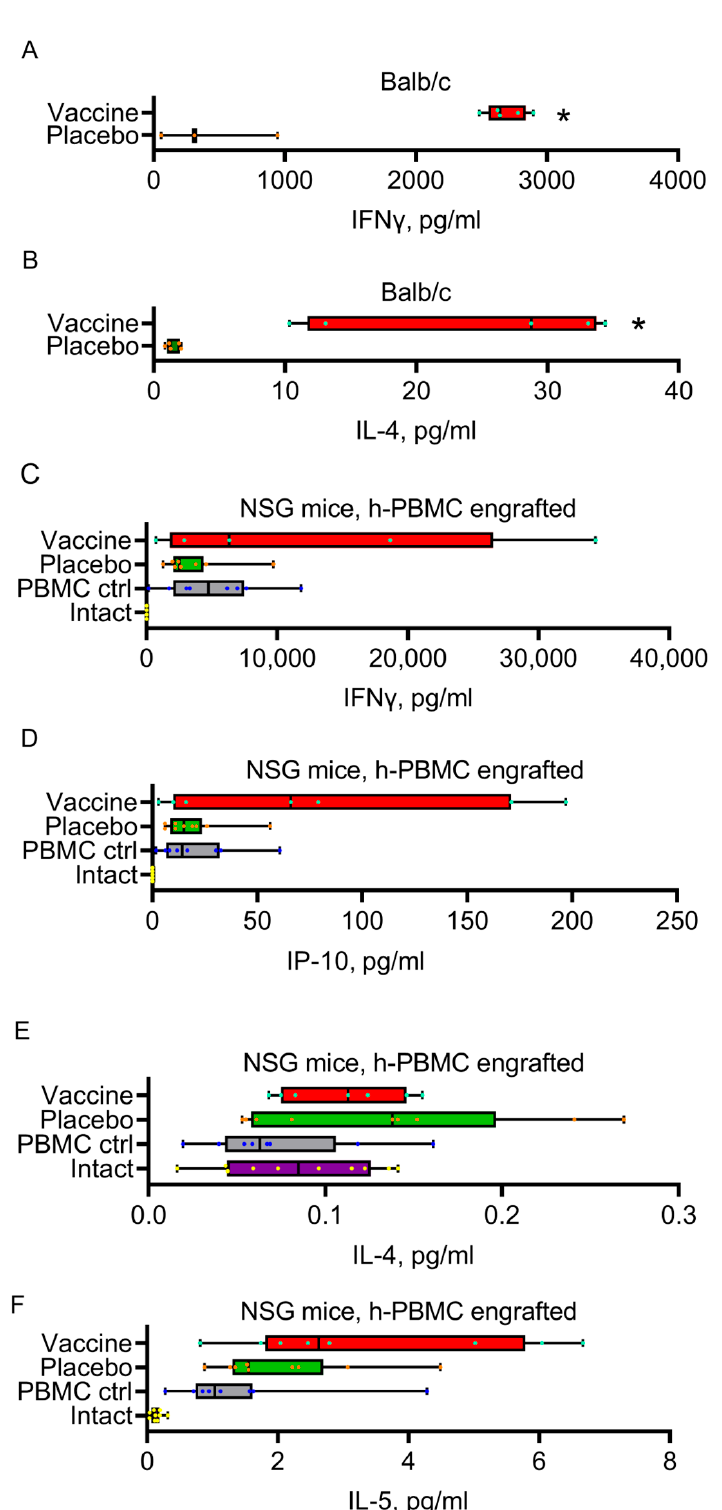
Figure 3. Murine IFN γ ( A ) and IL-4 ( B ) levels in supernatants of splenocytes isolated from Convacell ® -immunized or from non-immunized Balb/c. Human IFN γ ( C ), IP-10 ( D ), IL-4 ( E ) and IL-5 ( F ) levels in plasma from Convacell ® -immunized or from non-immunized NSG mice engrafted with human PMBCs. On panels C-F “PBMC ctrl” represents PBMC-engrafted NSG mice, “Intact” represents non-engrafted NSG mice. Statistically significant differences ( p < 0.05) according to the Mann–Whitney test with two-stage step-up are indicated with an asterisk.